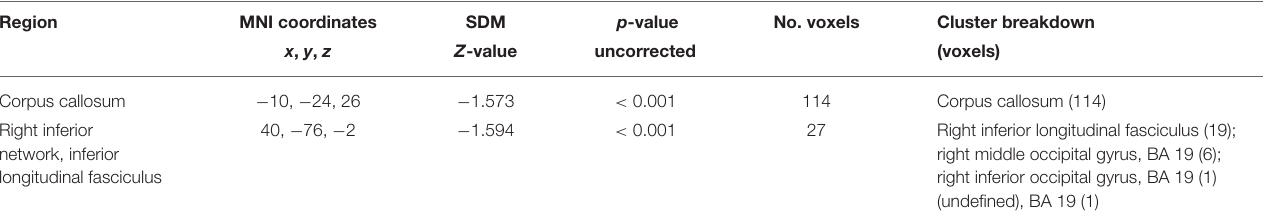
TABLE 3 | Clusters of fractional anisotropy reductions in all patients with TS relative to HCs.